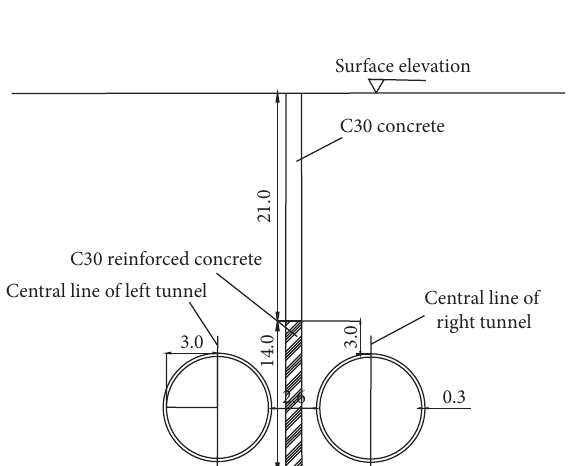
Figure 2: Plan view of isolation pile